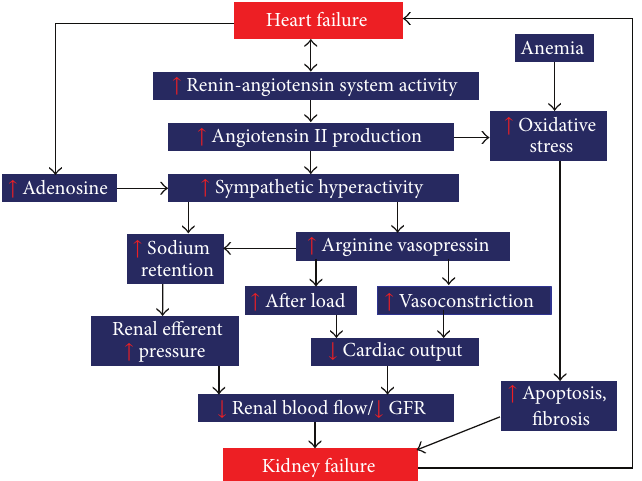
Figure 1: Schematic representation showing the pathophysiological interaction between heart and kidney in CRS and potential sites of intervention by herbal and traditional natural medicine (adapted from [11]). Red arrows indicate the direction of effects of known phytotherapeutic